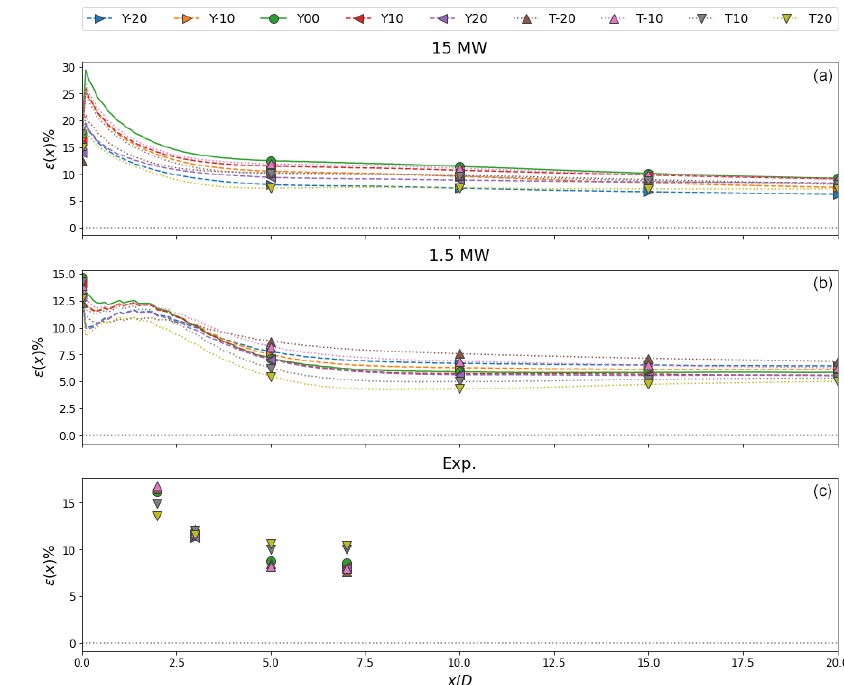
Figure 11. FLORIS streamwise flow field error using the existing formulation for the 15MW (a) , 1.5MW (b) , and scaled model turbine (c) inputs. Maximum error is present directly behind the turbine with a secondary peak near x/D = 2 for the 1.5MW cases. Error decreases with distance downstream for all cases except positive tilt angles which attain a local minima near x/D = 7 . 5.